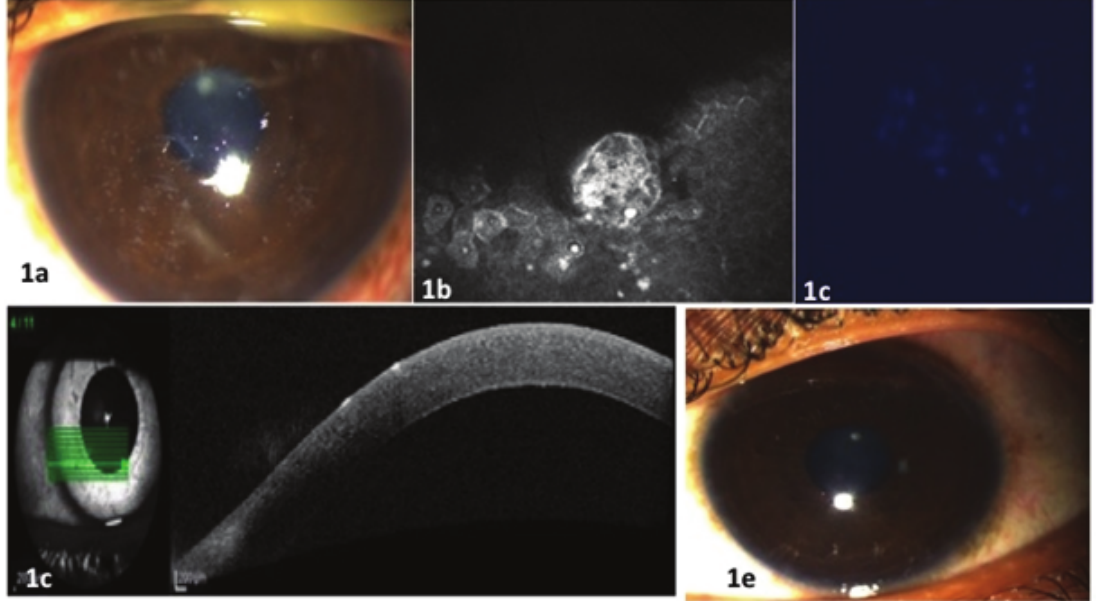
Figure 1. (a) Multifocal, coarse, white corneal epithelial infiltrates (b) In vivo confocal microscopy showing epithelial rosettes and intraepithelial pin–point hyperreflective spores (c) Combined potassium hydroxide-calcofluor white staining showing oval bluish fluorescent bodies (d) Anterior segment optical coherence tomography demonstrating stuck on plaques on the corneal surface (e) Slit lamp biomicroscopy showing clear cornea after